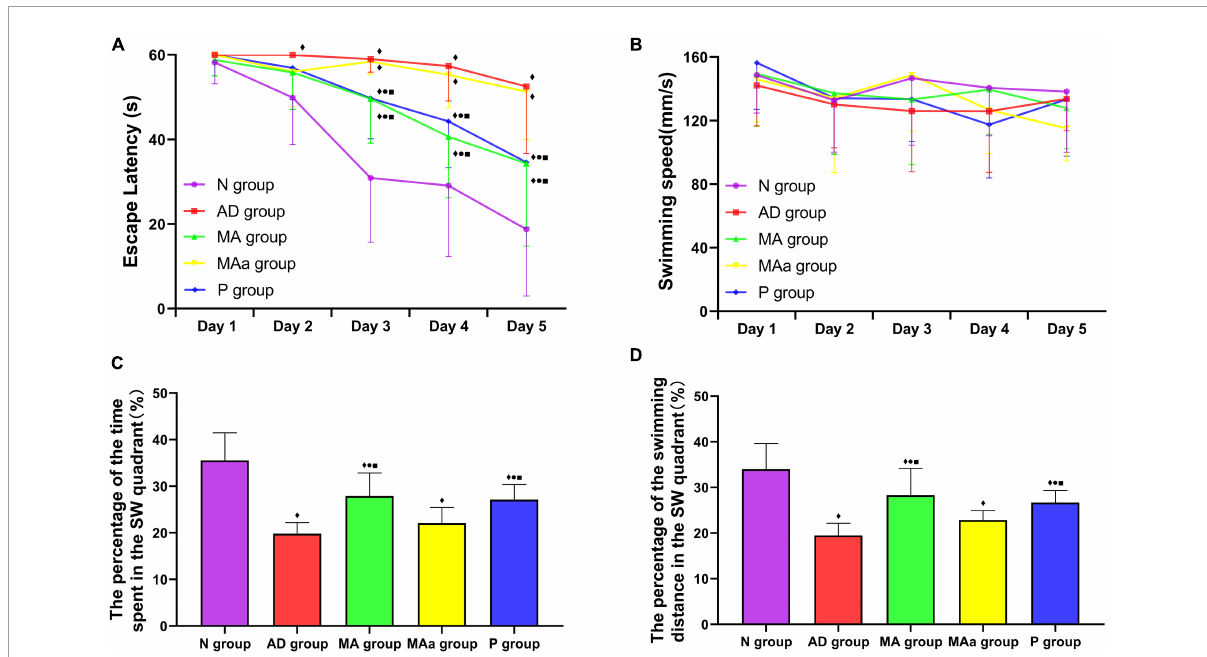
FIGURE1 Results of the MWM test for each group ( n = 10, mean ± SD). (A,B) Comparison of the escape latency and swimming speed of each group in the hidden platform trials. (C,D) Comparison between the percentage of time spent and swimming distances in the SW quadrant in each group. Compared to the N group, (cid:7) p < 0.01 or p < 0.05. Compared to the AD group, • p < 0.01 or p < 0.05. Compared to the MAa group, (cid:4) p < 0.01 or p < 0.05.